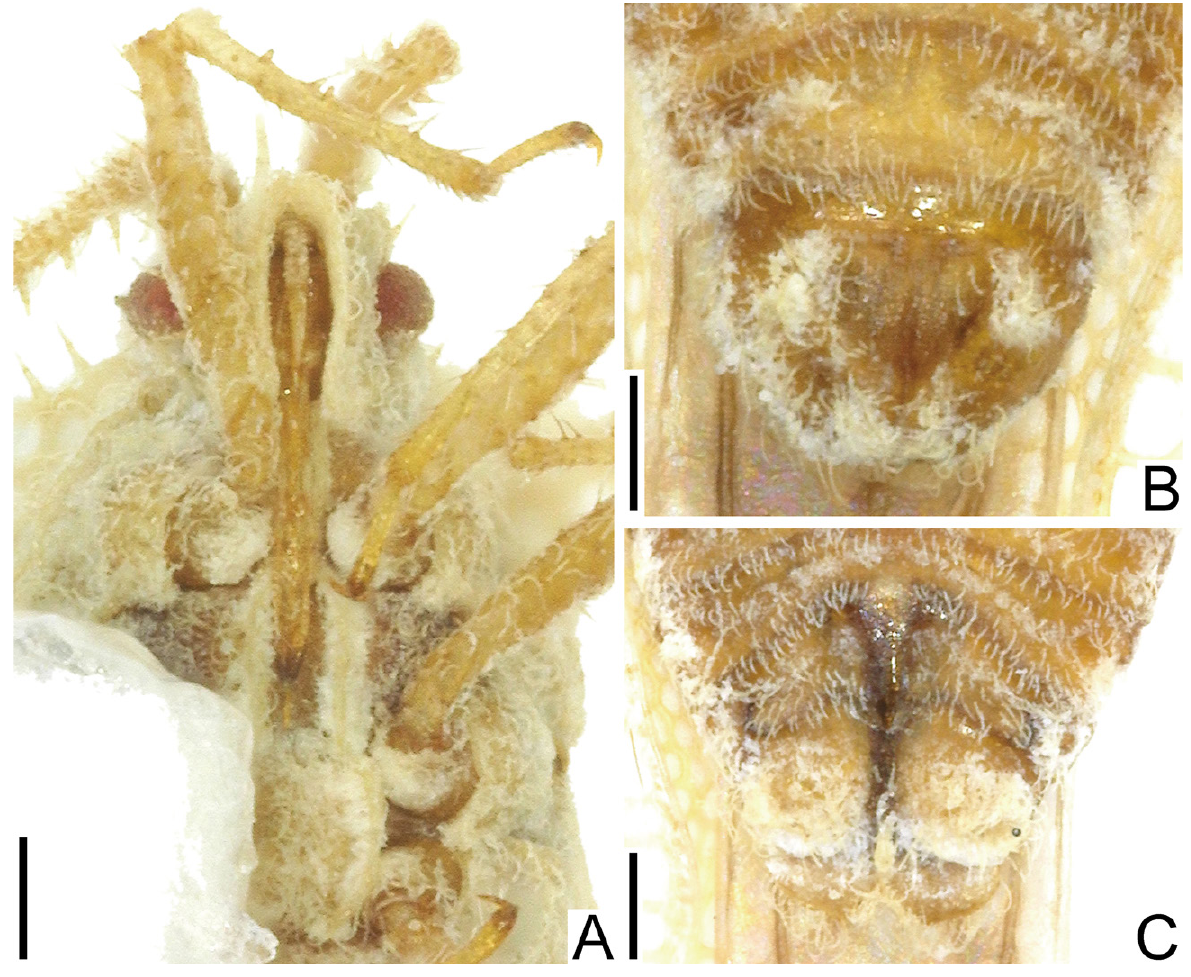
Figure 2. Detailed morphological images of Lasiacantha altimitrata . A. Male labium, ventral view. B. Male terminalia, ventral view. C. Female terminalia, ventral view. Scale bars: 0.2